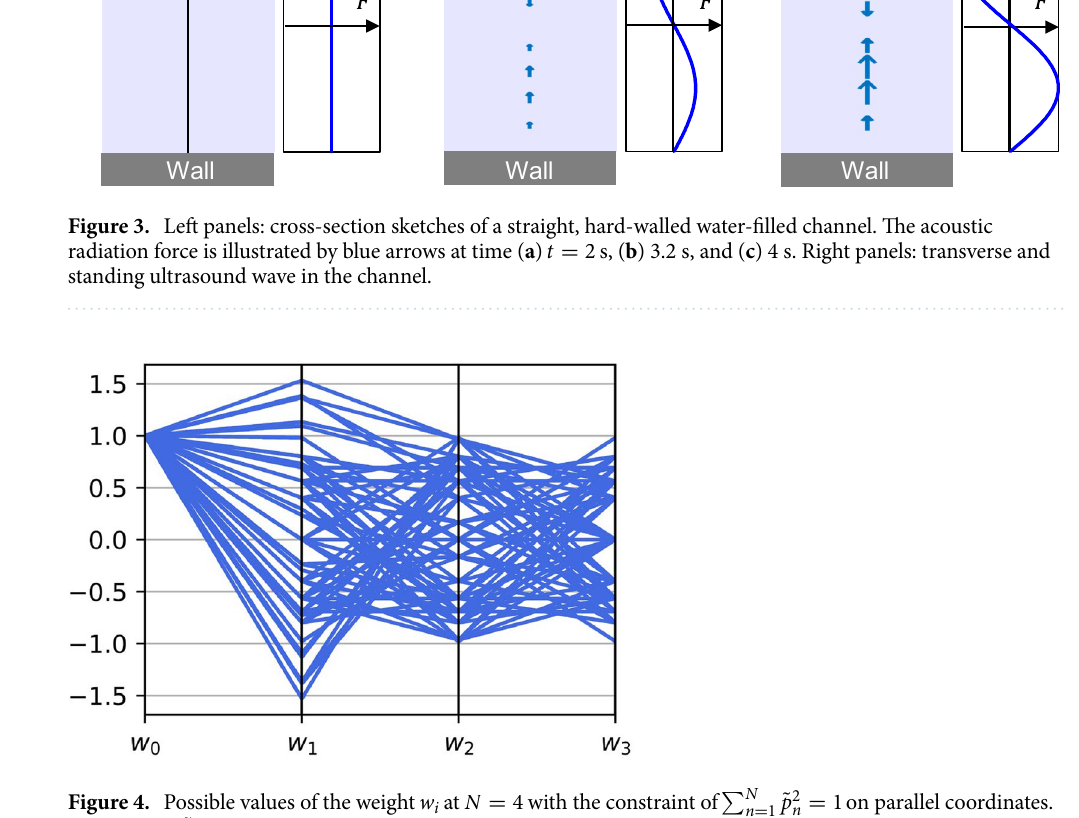
Figure 4. Possible values of the weight w i at N = 4 with the constraint of